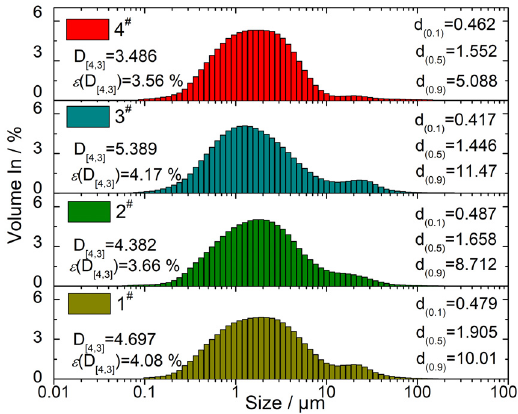
Figure 6. Particle size distributions of CCPs.